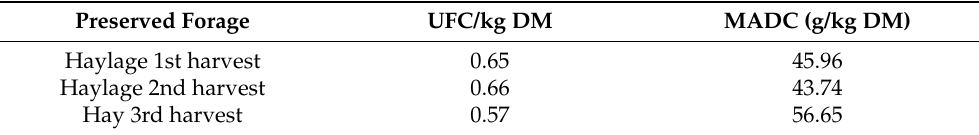
Table 3. Estimated energy (UFC—horse feed unit) and protein content (MADC—horse digestible crude protein) per kg DM, for haylage (1st and 2nd harvest) and hay (3rd